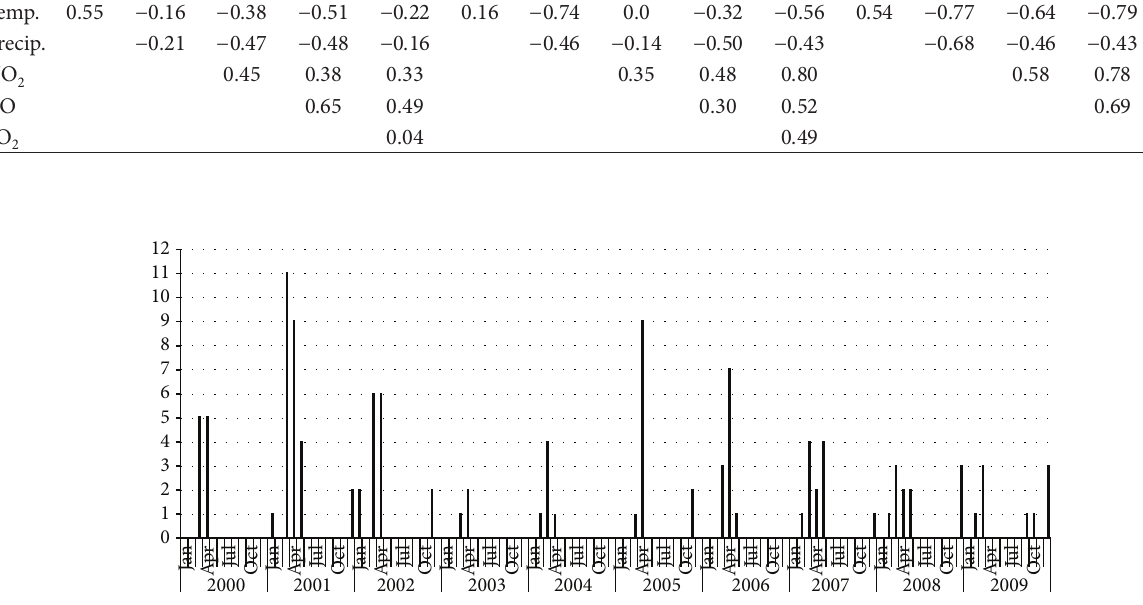
Figure 2: Dust event frequencies over the 10 years period.